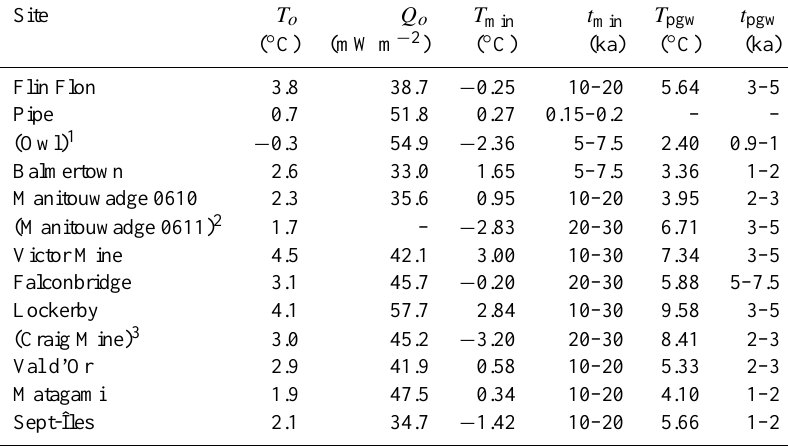
Table 2. Summary of GST history results where T o is the long-term surface temperature, Q o is the quasi-equilibrium heat flow, T min is the minimal temperature, T pgw is the maximum temperature attained during the postglacial warming, and t min and t pgw are the occurrence of the minimal temperature and maximum postglacial warming temperature. Parentheses indicate sites where the GST history is not reliable. Site